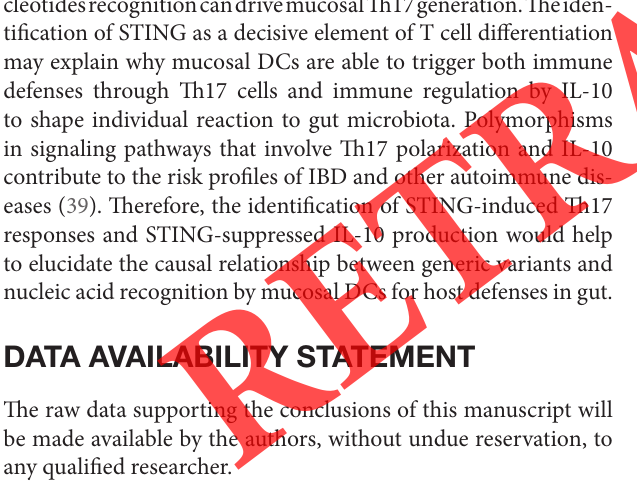
FigUre s1 | Lamina propria DCs separation strategy by flow cytometry. Cells from small intestine lamina propria were prepared according to the description in Section “Materials and Methods” and were sorted using FACSCalibur flow cytometer (BD Bioscience) and analyzed by FlowJo software (Tree Star). Initially, FSC/SSC gating was employed to exclude debris and identify cell population of interest, followed by DAPI − to exclude dead cells and CD3 − to exclude T cells. Subsequently, CD11c int/hi MHCII + was used to yield all DC populations, which were then separated into CD103 + or CD103 − population according to their CD103 expression. The expression of B220 in CD103 + and CD103 − populations were analyzed. The co-expression of CD11b and CD103 on DCs was analyzed as well. FigUre s2 | Separation strategy of DCs in mesenteric lymph nodes and spleen by flow cytometry. Cells from mesenteric lymph nodes or spleen were prepared according to the description in Section “Materials and Methods” and were sorted using FACSCalibur flow cytometer (BD Bioscience) and analyzed by FlowJo software (Tree Star). Initially, FSC/SSC gating was employed to exclude debris and identify cell population of interest, followed by DAPI − to exclude dead cells. CD11c + CD103 + was subsequently used to identify CD103 + DCs in respective